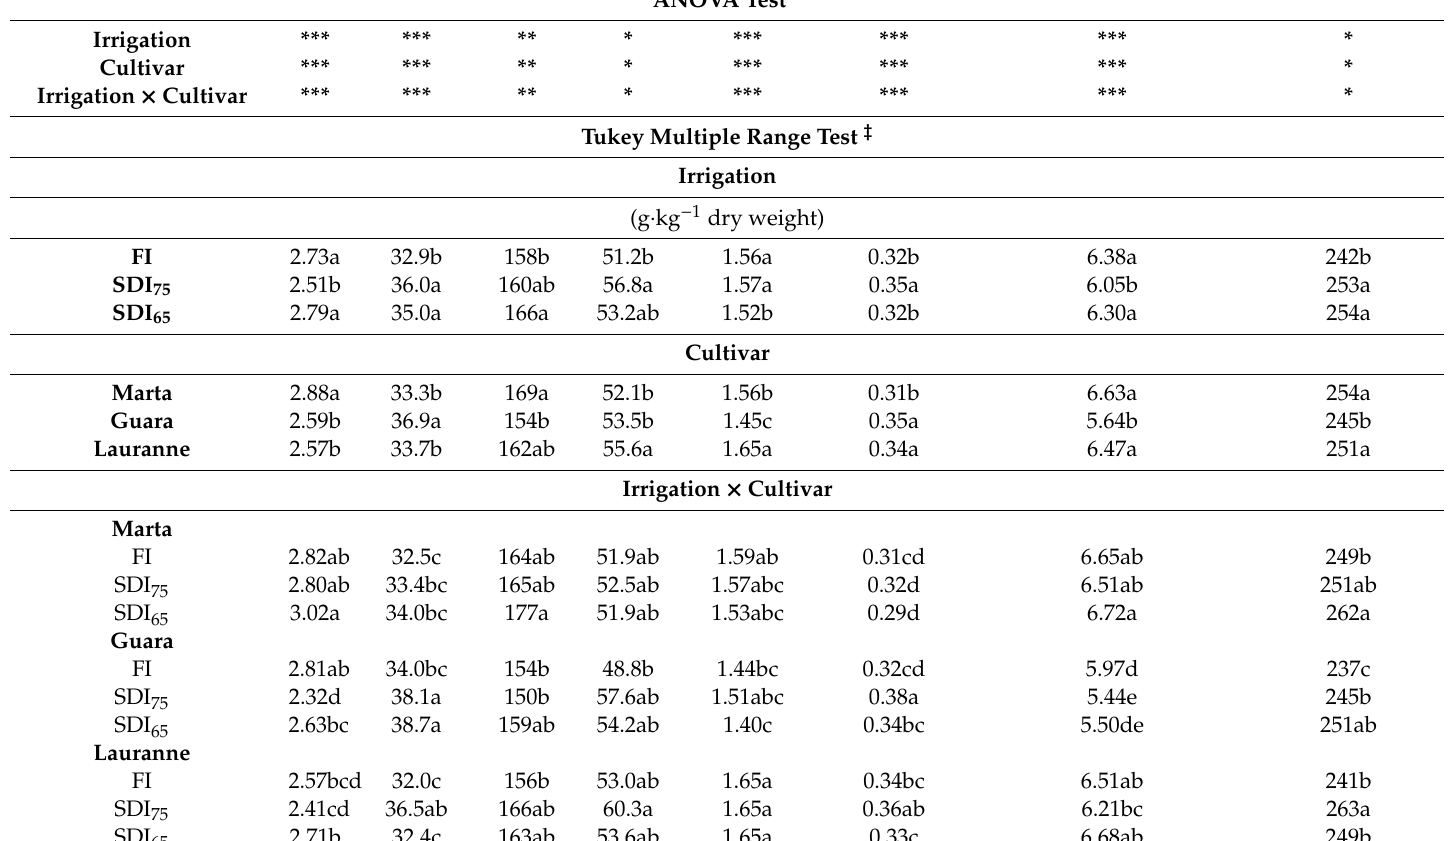
Table 8. Types of fatty acids, ratios, and health indices in di ff erent almond cultivars under sustained deficit irrigation. O:L SFA MUFA PUFA PUFA:SFA PUFA:MUFA (MUFA + PUFA) / SFA Total fatty acids ANOVA Test †